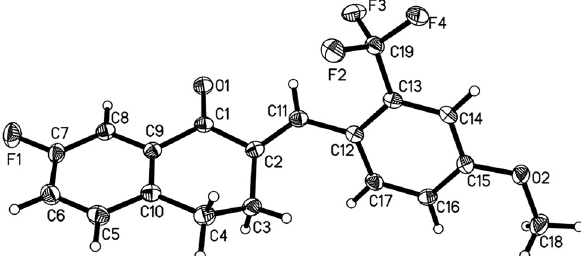
Table  : Data collection and